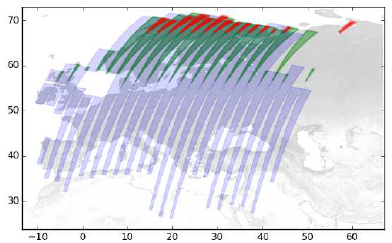
Figure 1. Sentinel-2 swath overlap over Europe. Blue areas represent overlap between adjacent orbits, while green (resp. red) areas represent overlap between 1 orbit (resp. 2 orbits)